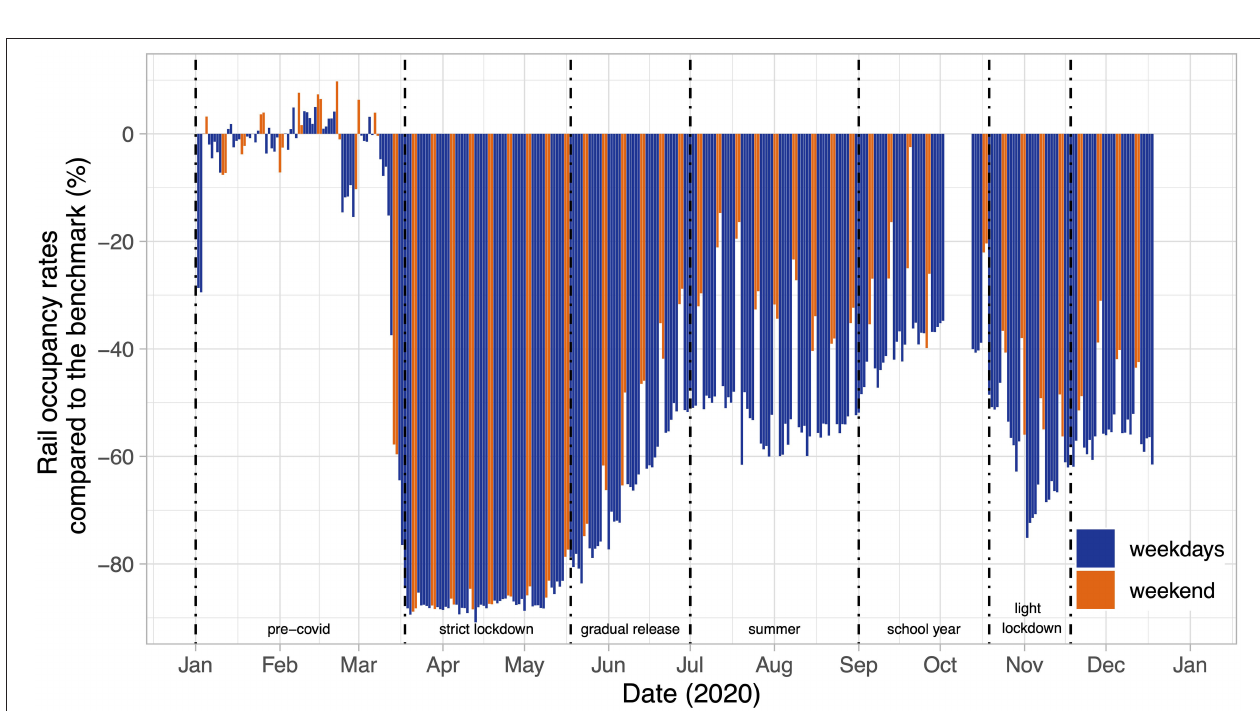
FIGURE 4 | Evolution in the train occupancy rates compared to the pre-lockdown benchmark (data source: SNCB-NMBS). Outliers includes the car free Sunday on September 20 when the occupancy rate almost reached the benchmark.